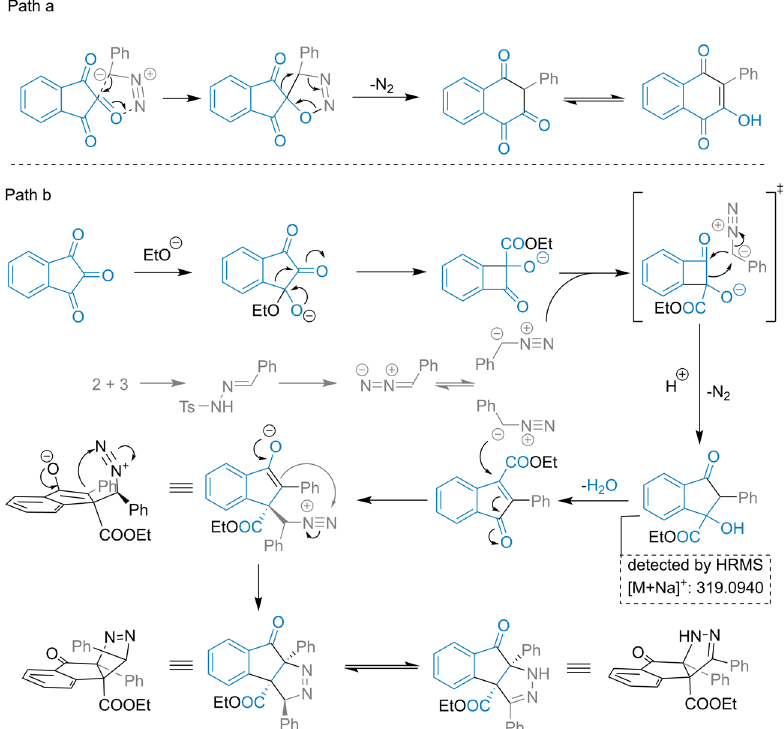
Fig. 7 Proposed mechanism. a Reaction formation mechanism of Lawson derivatives. b Reaction formation mechanism of indenopyrazole